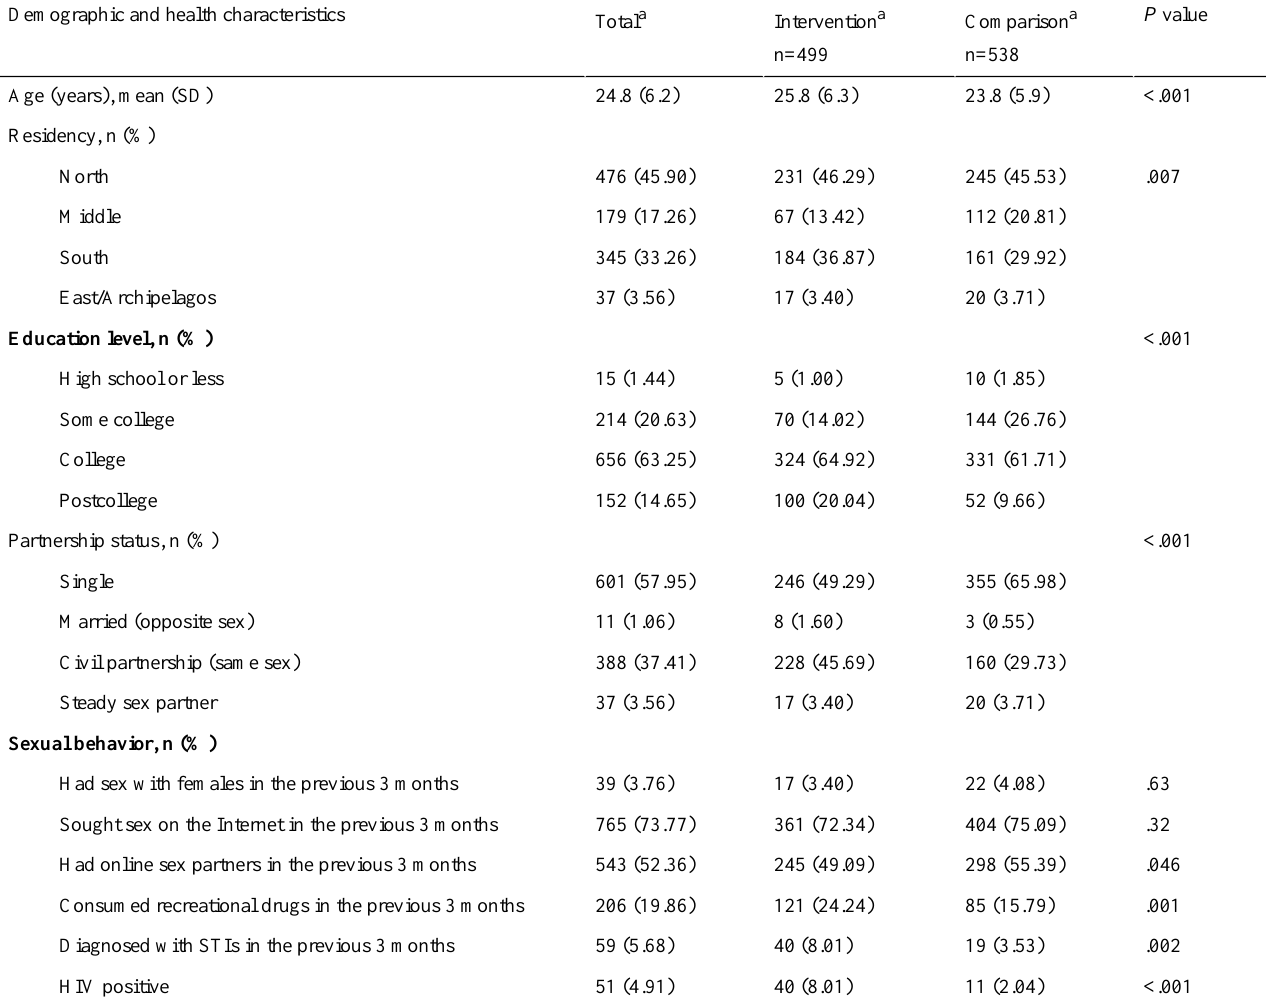
Table 1. Comparison of demographic and health characteristics between participants in the comparison and intervention (iPOL on Facebook) groups